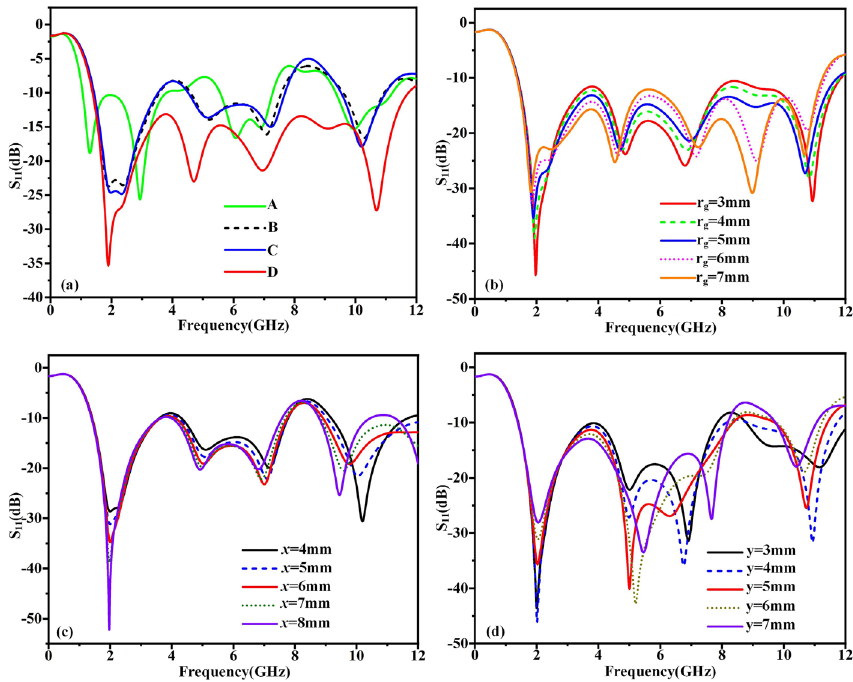
Figure 2. ( a )The reflection coefficients of Stru.A, Stru.B, Stru.C and Stru.D, respectively. ( b – d ) The UWB performance optimization of